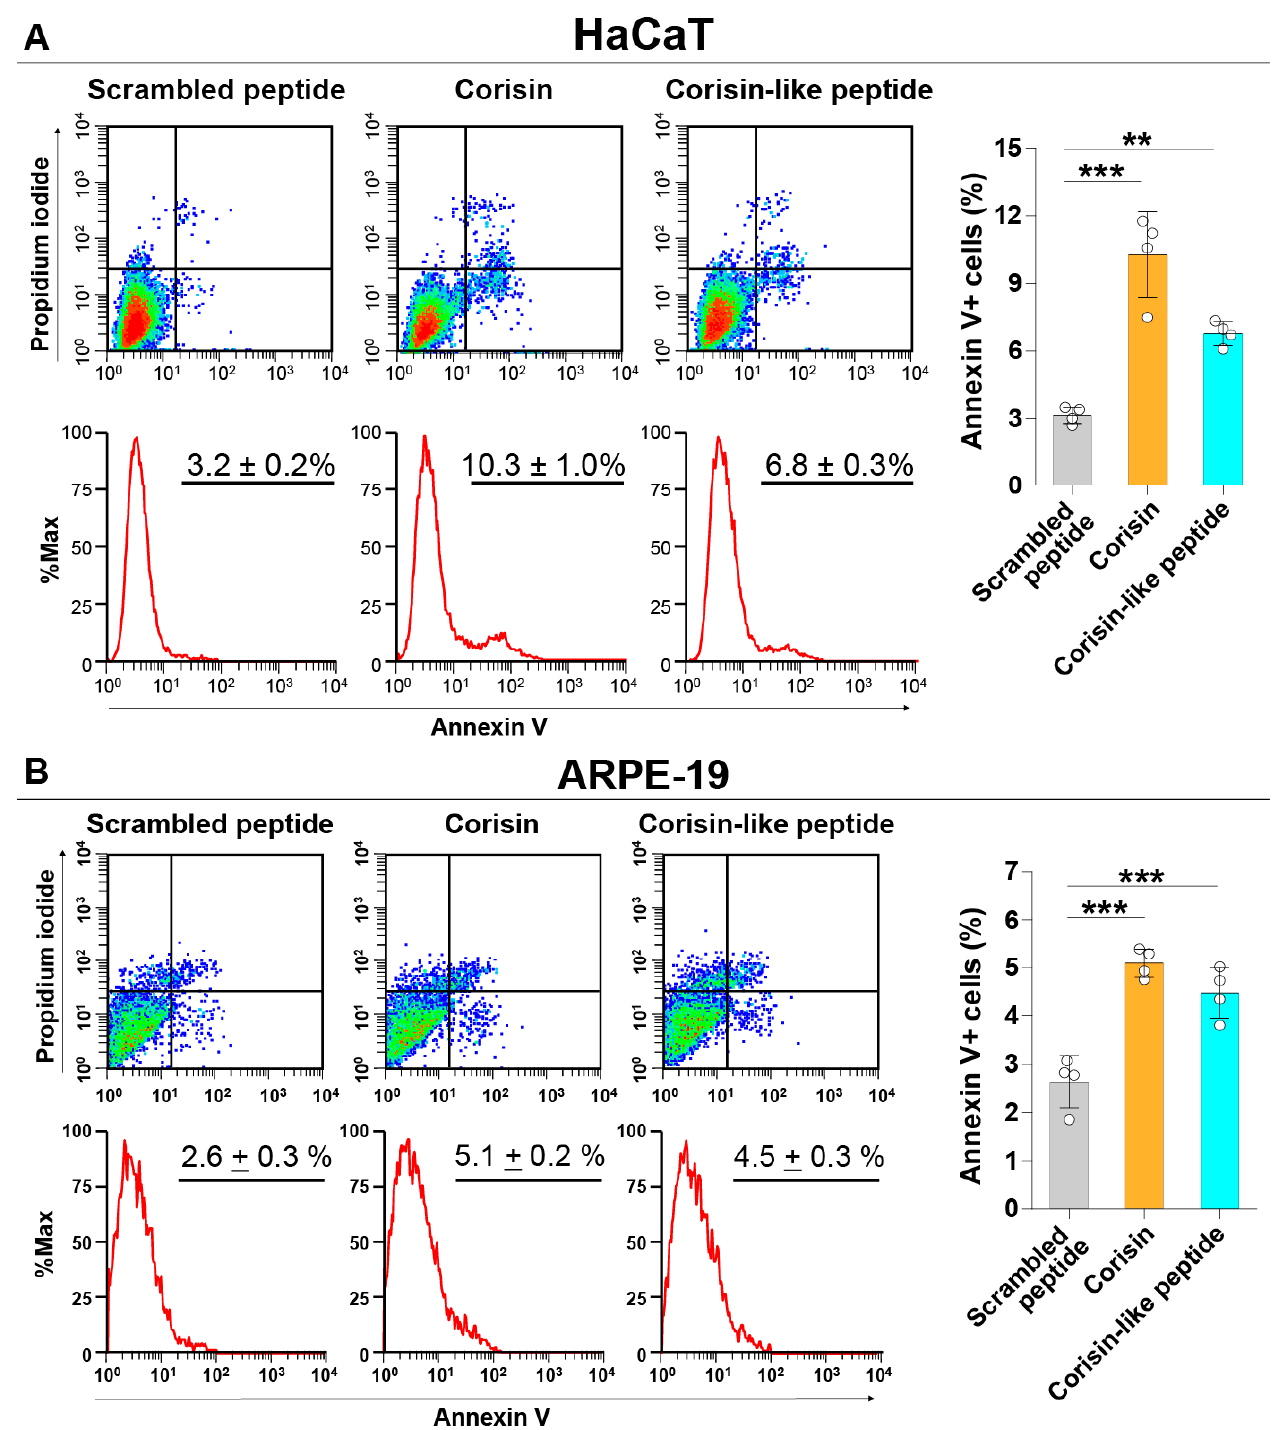
Figure 2. Corisin and corisin-like peptides induce apoptosis of keratinocytes and retinal cells. HaCaT ( A ) cells and ARPE-19 cells ( B ) were cultured in the presence of corisin or corisin-like peptide for 48 h, and apoptosis was evaluated by flow cytometry. Data are expressed as the mean ± S.D. Statistical analysis by ANOVA with Newman-Keuls' test. ** p < 0.01; *** p < 0.001.